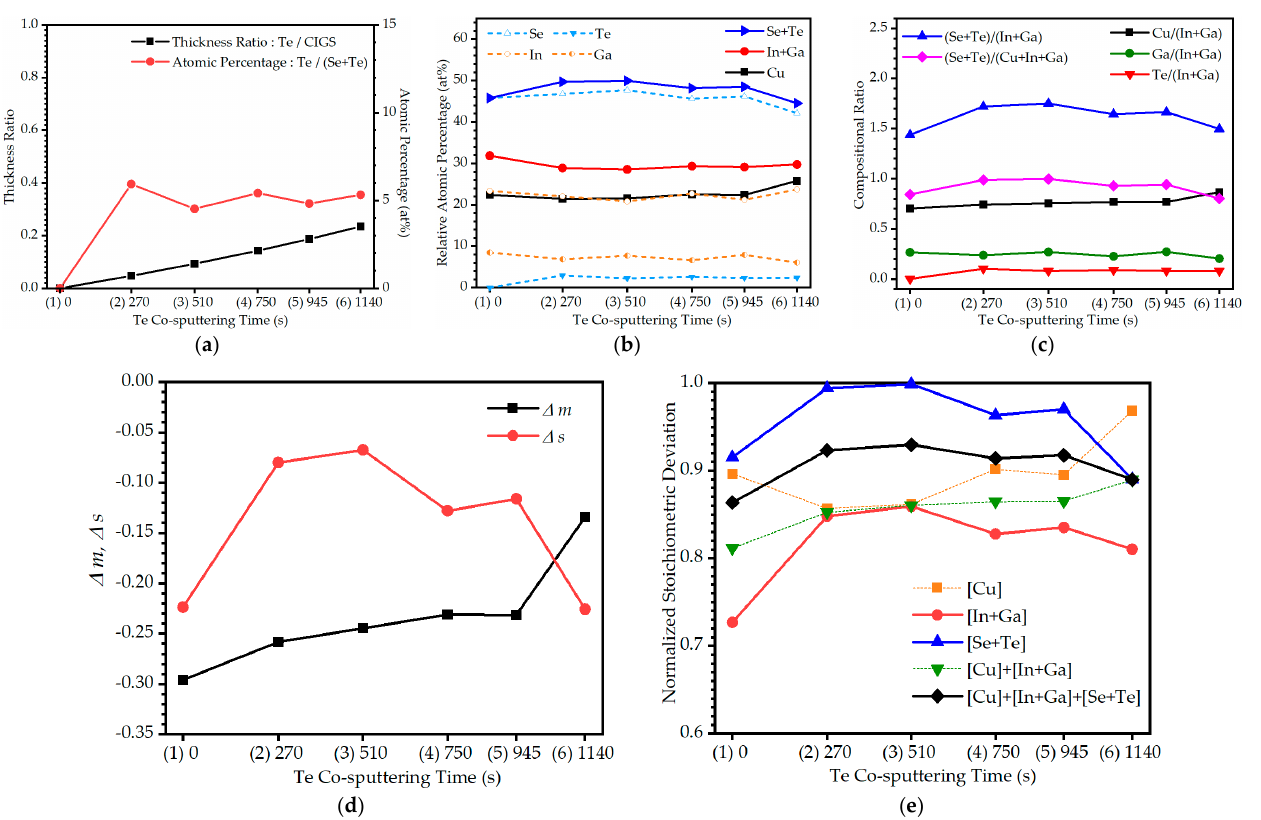
Figure 2. Energy dispersive X-ray spectroscope (EDX) analyses of the CIGS:Te thin films with different Te co-sputtering times of (1) 0, (2) 270, (3) 510, (4) 750, (5) 945, and (6) 1140 s. ( a ) Thickness ratio and atomic percent, ( b ) relative atomic percentage, ( c ) compositional ratio, ( d ) deviation parameters from the molecularity and the stoichiometry, Δ m and Δ s , and ( e ) normalized stoichiometric deviations.